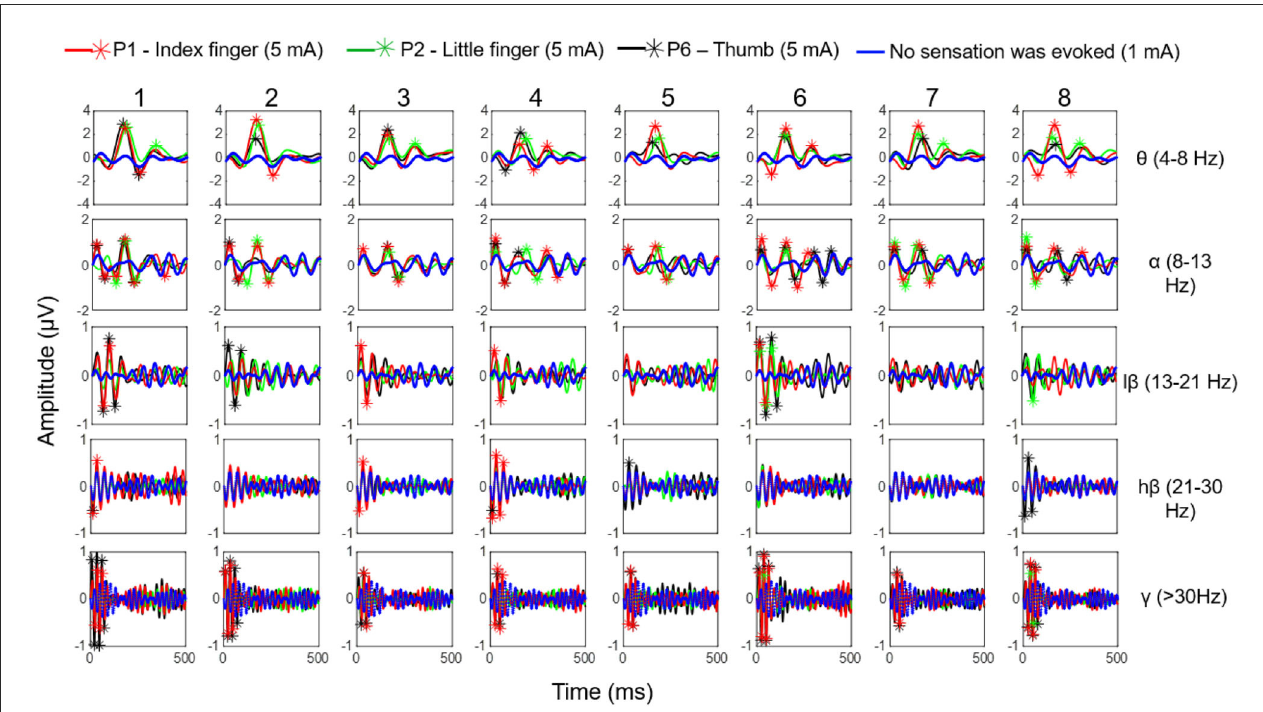
FIGURE12 The ERP curves when stable sensations of the index finger, little finger, and thumb were evoked at stimulus positions P1, P2, and P6 under the amplitude of 5mA as well as no sensation was evoked under the amplitude of 1mA, in eight experiments (in MS pattern) for subject 1